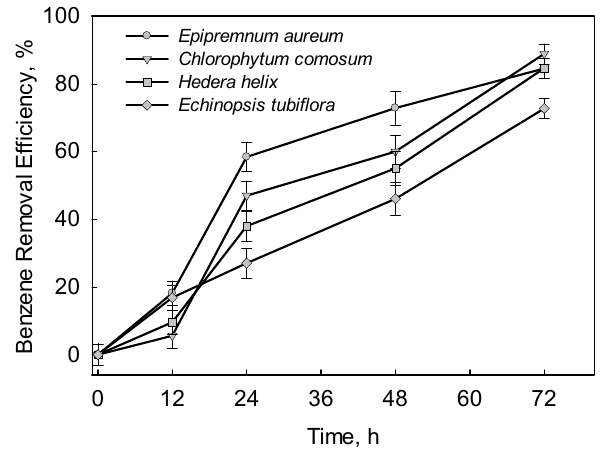
Figure 2. Benzene removal efficiency of Epipremnum aureum , Chlorophytum comosum , Hedera helix and Echinopsis tubiflora . The error bar indicates the standard deviation for three replicates.